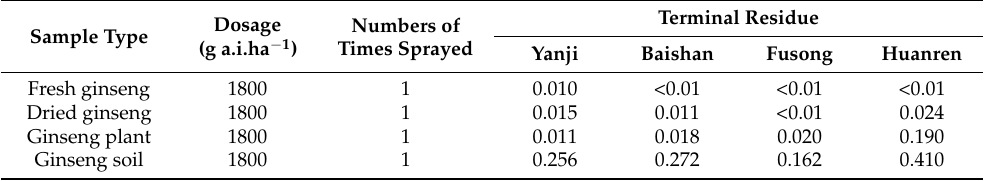
Table 2. Final residue of butralin in fresh ginseng, dried ginseng, ginseng plant, and ginseng